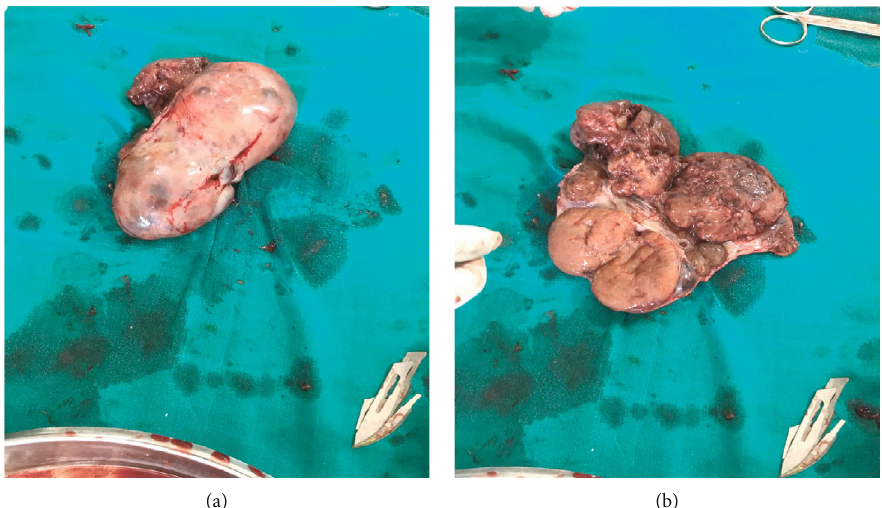
Figure 2: (a, b) A whole section of the enlarged left ovary after unilateral oophorectomy.